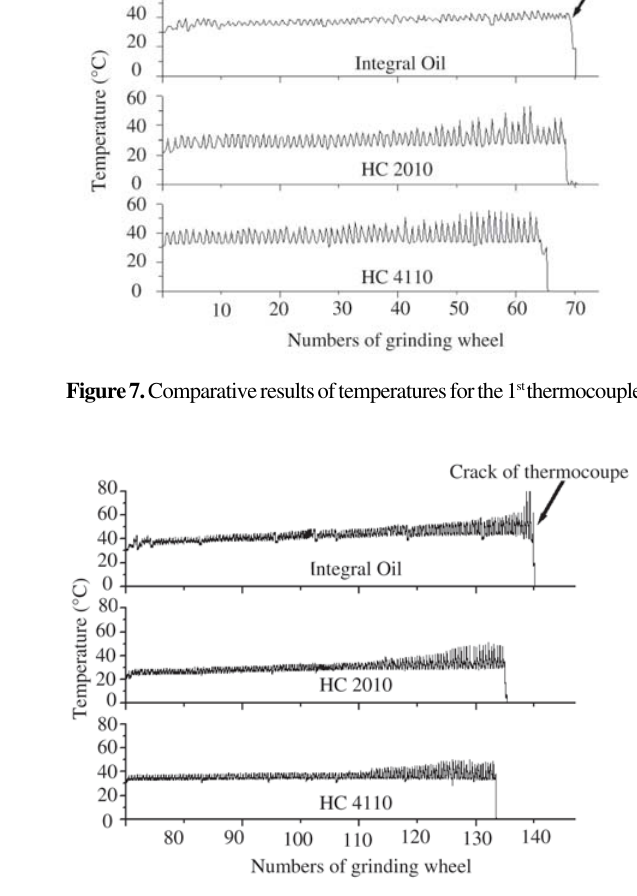
Figure 8. Comparative results of temperatures for the 2 nd